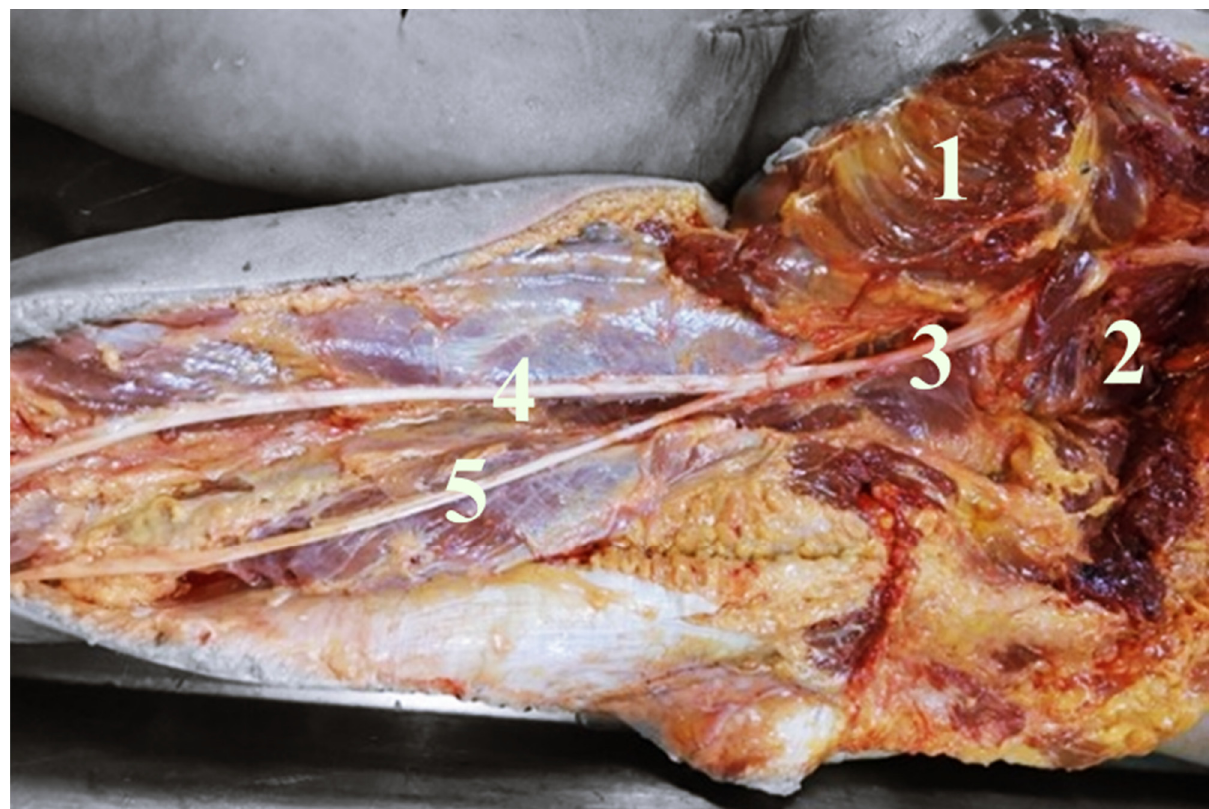
Figure 3. It shows a deep right gluteal region and right posterior femoral region. Gluteal major muscle retracted (1), PM (2). In this case, the SN divides into tibial nerve (3) and common peroneal nerve (4) in the gluteal region.